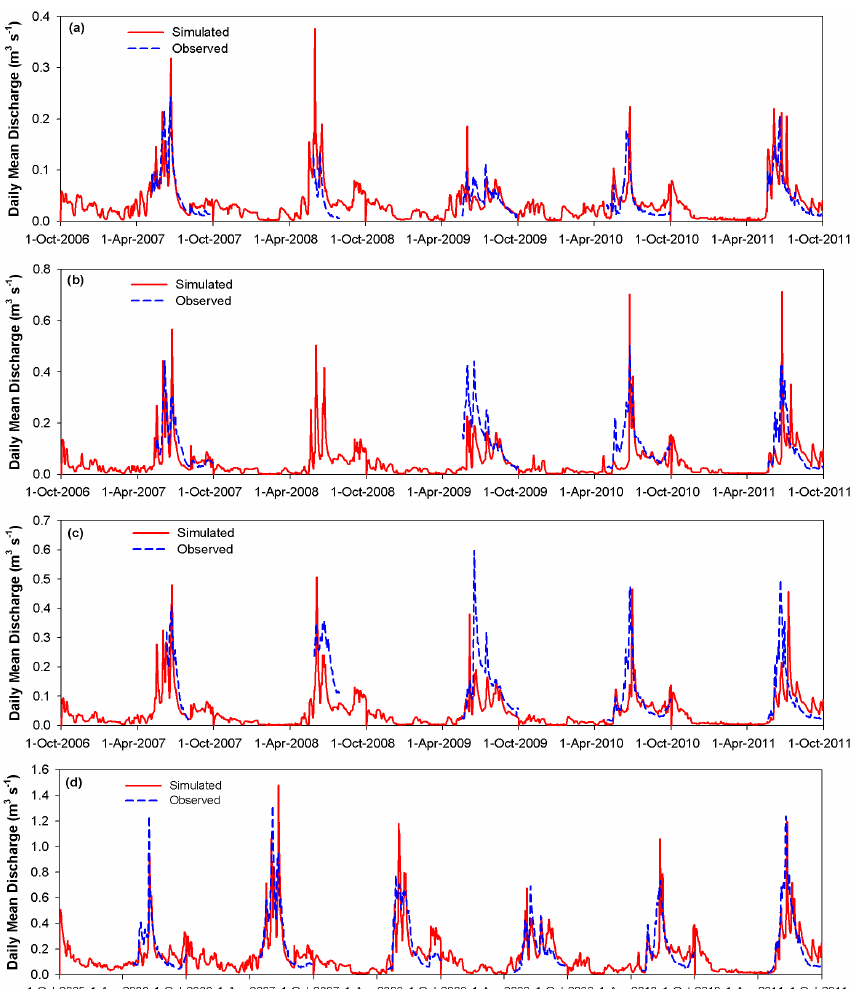
Fig. 10. Comparisons of observed and simulated daily streamflow for 2005–2011 at the outlets of (a) Cabin Creek, (b) Middle Creek, (c) Twin Creek, and (d) Marmot Creek. Note that streamflow observations for Cabin, Middle, and Twin creeks started in spring 2007 and no measurements were available for Middle Creek in 2008 due to disturbance from